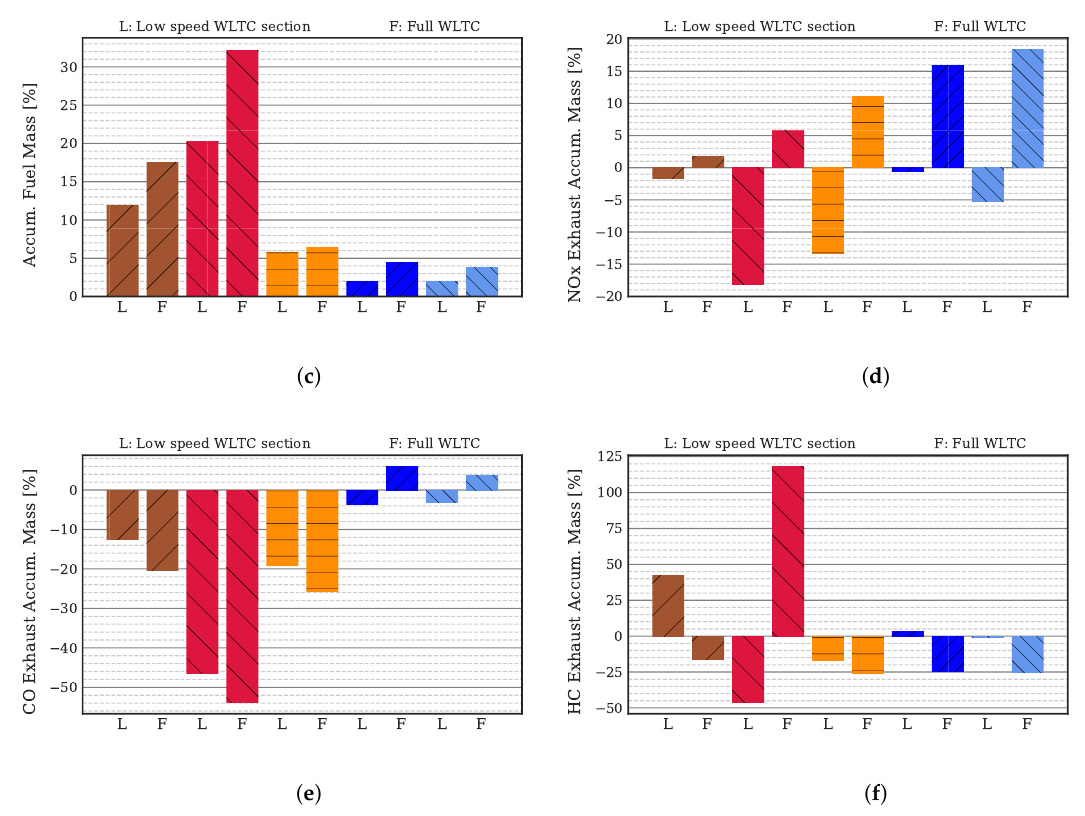
Figure 15. WLTC model results during the low speed stage and the whole cycle, engine start at 20 ◦ C ambient temperature. Percentage variation compared to the baseline case. ( a ) Time to reach DOC light-off temperature; ( b ) Time to reach coolant thermostat threshold; ( c ) Accumulated fuel consumption; ( d ) Accumulated engine-out NO x emissions; ( e ) Accumulated CO emissions at DOC outlet; ( f ) Accumulated HC emissions at DOC